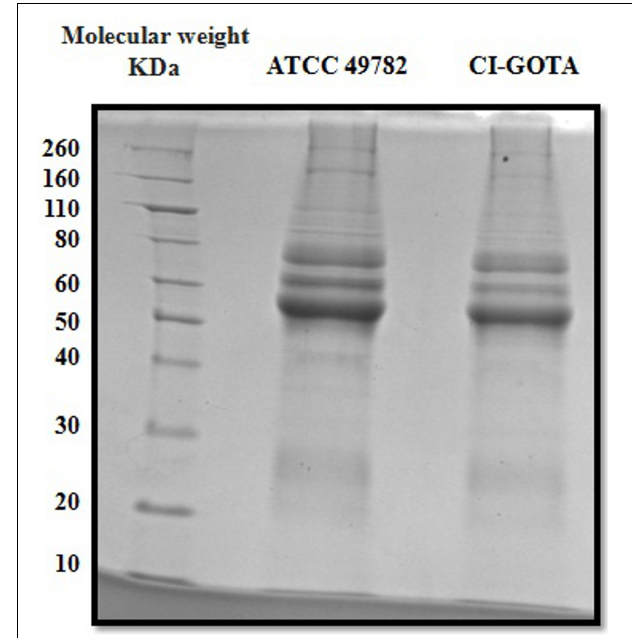
FIGURE 3 | SDS-PAGE of the UdLAMPs. First column: Novex Protein molecular weight. Second column: UdLAMPs from ATCC 49782. Third column: UdLAMPs from